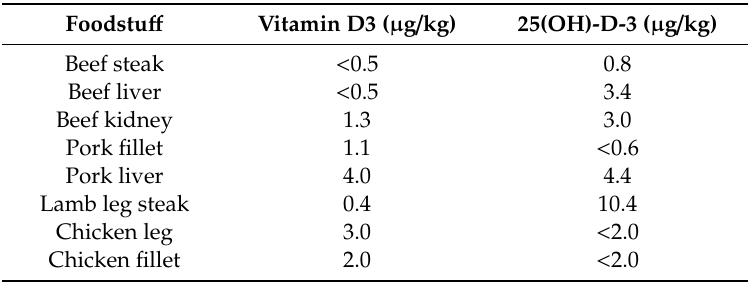
Table 2. Vitamin D3 and Calcidiol (25(OH)-D-3) content in meat and o ff